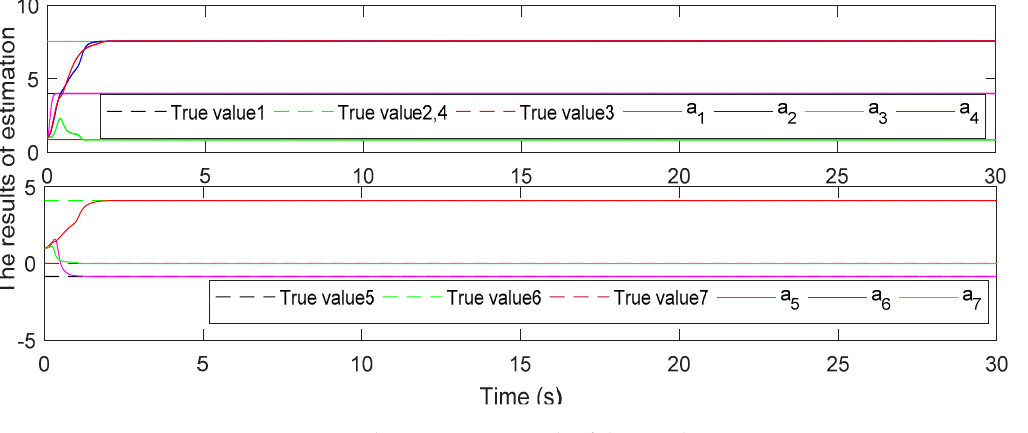
Figure 2. The estimation result of the quadrotor.